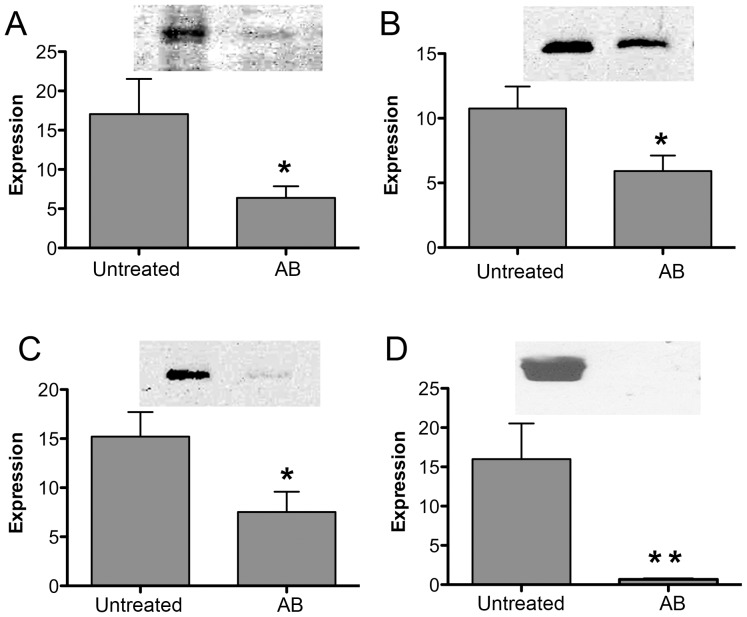
Western-blot.
Panel A: Laminin receptor. Panel B: pyrophosphatase 1. Panel C: HSPB1. Panel D: haptoglobin. Expression levels are presented as mean±SEM. * p<0.05 in AB vs untreated pigs.